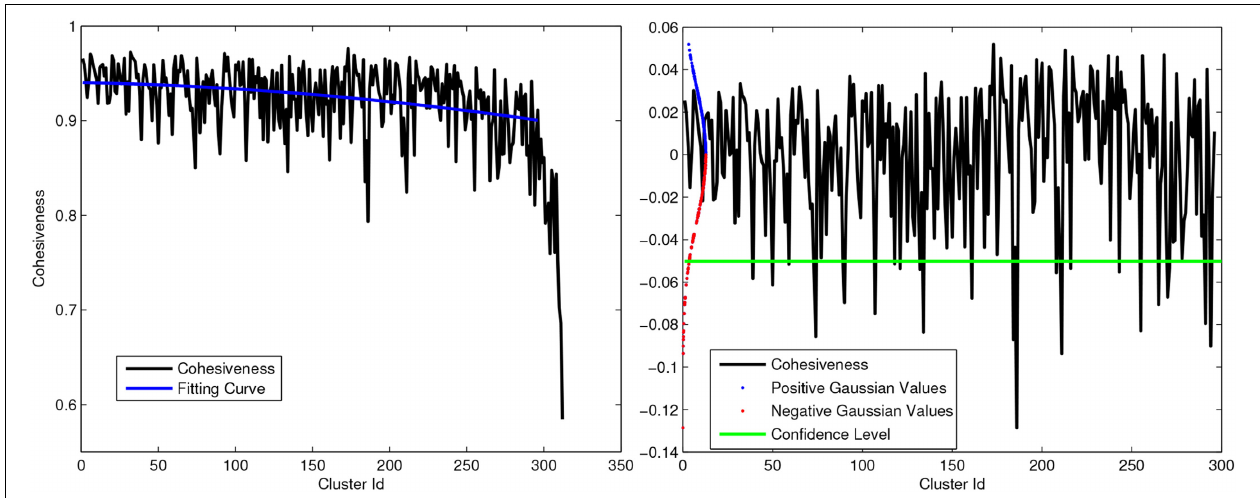
FIGURE 3 | Left: Example of Cohesiveness curve and polynomial fitting. Right: Strategy to remove outliers from intra-subject clustering using gaussian curve and statical test. All positive peaks and negative above green line are considered as significant for multi-subject clustering.